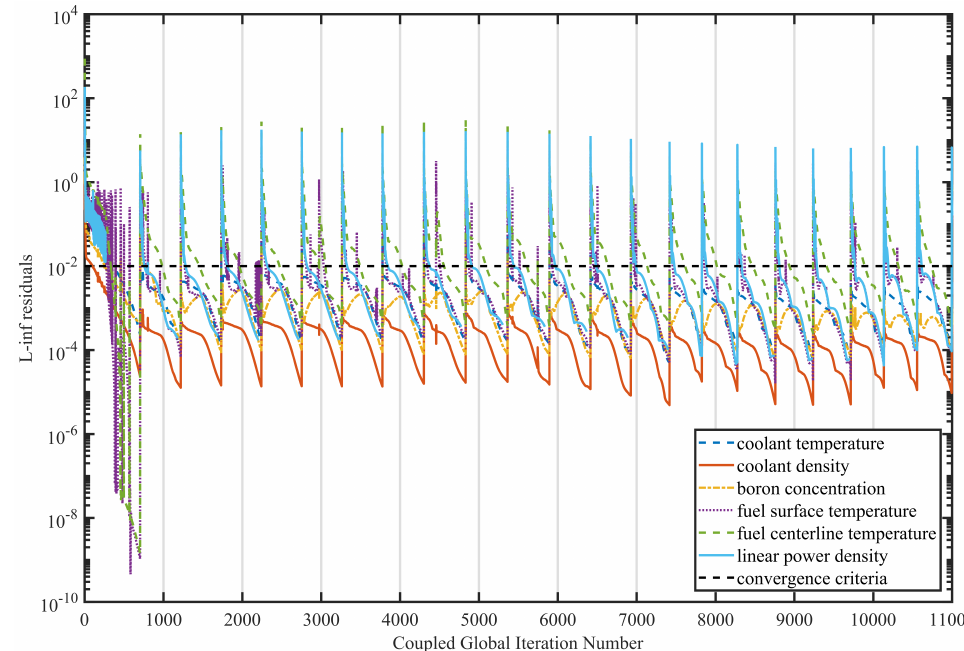
Figure 8. Details of the coupled depletion